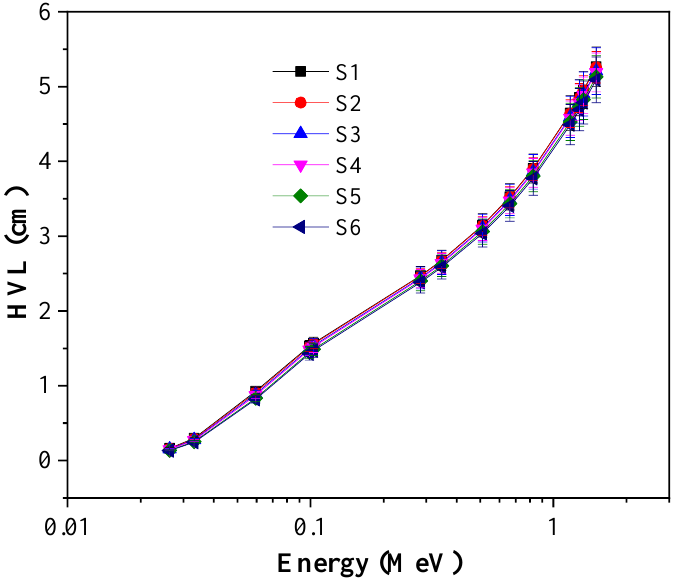
Figure 8. HVL of glasses as a function of energy.